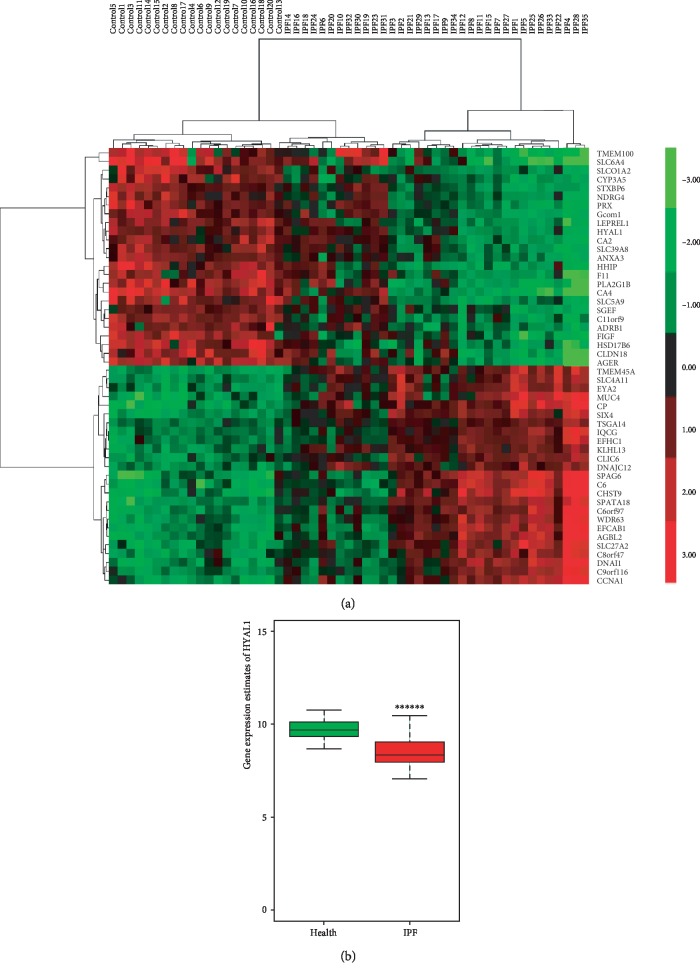
Human lung tissue gene expression. (a) Heat map of the top 50 gene signatures in the selected lung tissues of IPF (n = 35) vs. control (n = 20) from merged gene expression profiling data of GSE24206, GSE10667, and GSE16538. Samples were selected by two-way clustering, and gene signatures were filtered by unpaired t test, SVM and PCA methods. Red, green, and black pixels indicate high, low, and medium expression levels, respectively. Sample details were summarized in the supplementary file . (b) Box plot showing the relative HYAL1 gene expression levels in IPF lung tissue (n = 35) vs. healthy control (n = 20; P < 0.000001).The P values were calculated using the unpaired t test.